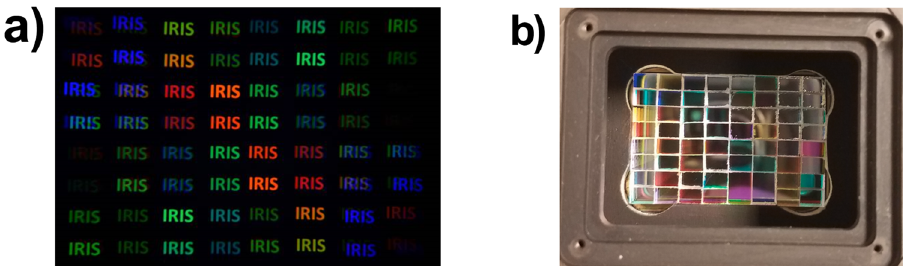
Fig. 6 Birefringent spectral demultiplexer output and mosaic interference fi lter. a BSD view of the word “ IRIS ” displayed in white letters on a computer monitor. Channels that appear dark have their peak transmission wavelength falling outside of the emission range of the computer monitor. b Hand crafted mosaic interference fi lter mounted on the camera sensor.